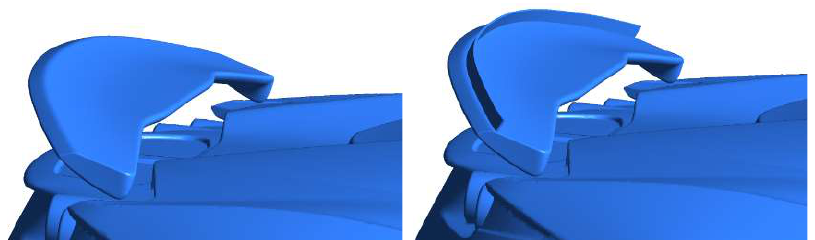
flap retracted, right with it extended.